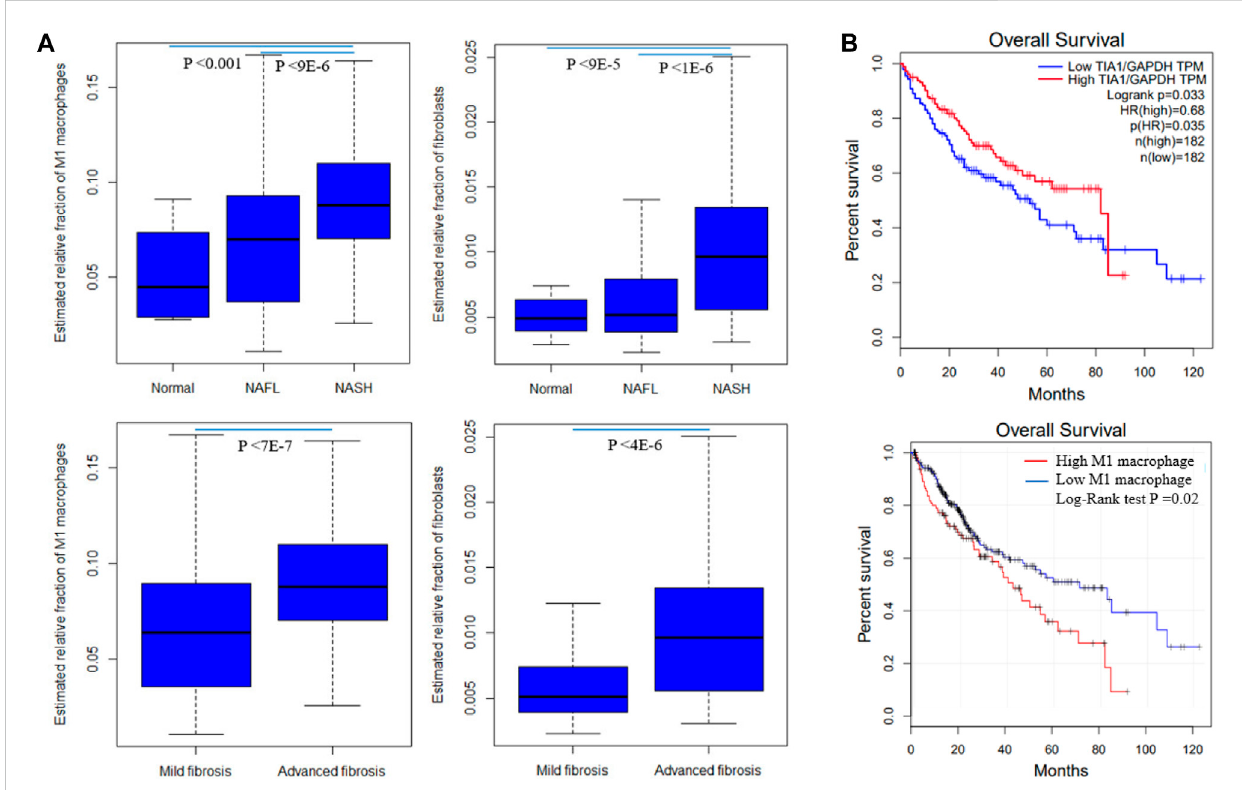
FIGURE 5 FibroblastandM1macrophageinNAFLDandHCC. (A) DifferentiallyexpressedfractionsofM1macrophagesand fi broblastsinpatientswithdifferent NAFLDstagesand fi brosisstagesinGSE135251 (B) M1macrophageandhubgene Tia1 areassociatedwithHCCpatientssurvivalintheTCGAdataset. Tia1 is the hub gene of M15 which is negatively correlated with M1 macrophage proportion. The log-rank derived p -value indicates the signi fi cance of the comparison between groups. Statistical signi fi cance was calculated by Student ’ s t-test for mild and advanced fi brosis comparison, or ANOVA for normal, NAFL, and NASH